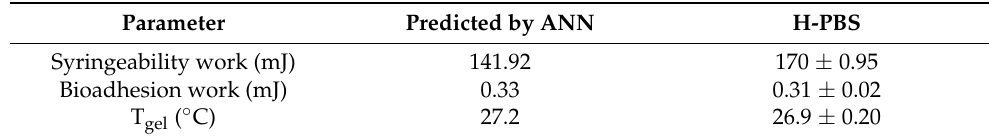
Table 2. Texturometric and rheological values predicted by the ANN model and experimental values obtained after hydrogel characterization. Data are presented as mean ± SEM.